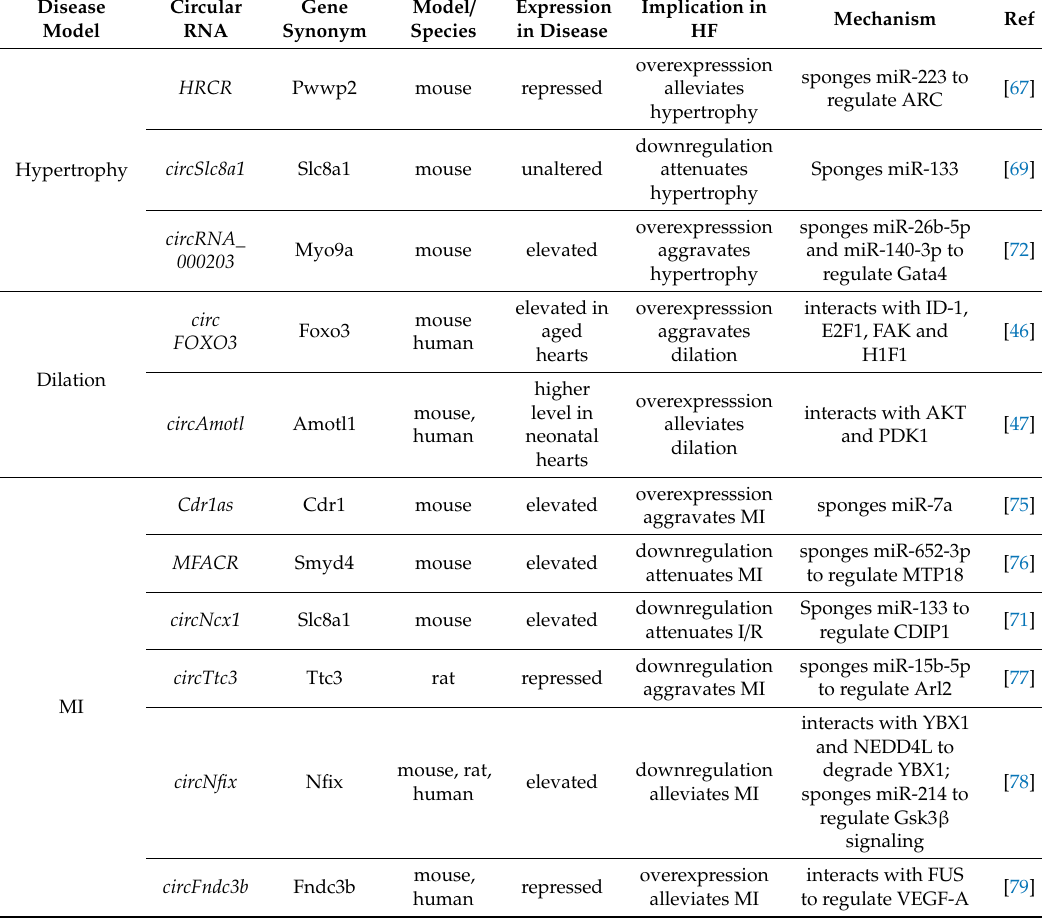
Table 2. List of functional circRNAs associated with heart failure (HF). All the studies cited in the table provided both in vitro and in vivo evidence. MI, myocardial